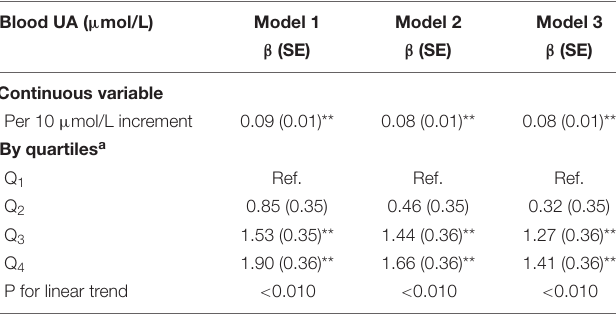
TABLE 1 | Cross-sectional associations of blood UA levels with the cognitive score.